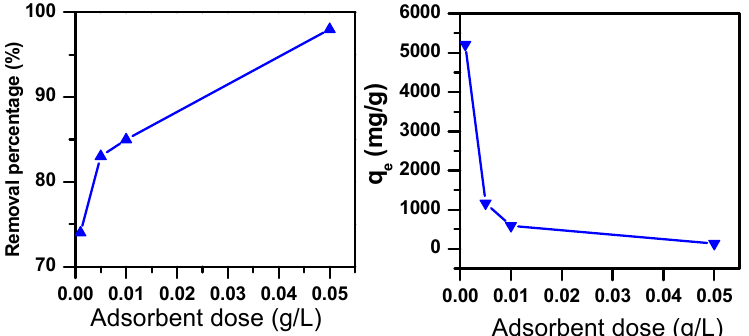
Figure 2. Removal efficiency of Fe 2 (MoO 4 ) 3 in a 70-ppm MB solution as a function of the adsorbent dose (t = 30 min, T = 20 °C).